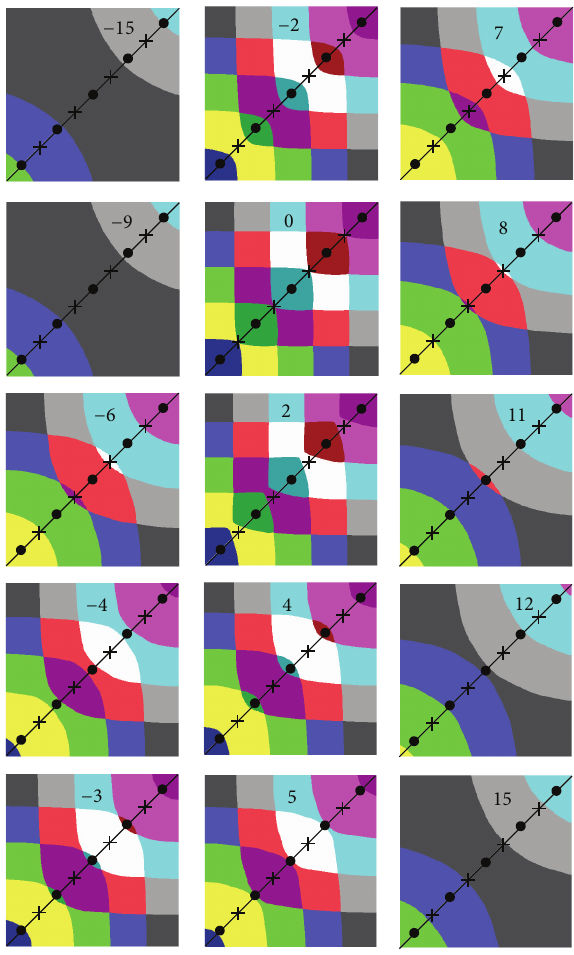
Figure 7: The projections of cross-sections into 𝑢 2 , 𝑢 1 plane for the parameters (5) and current denoted in the figure (in mA), where N 2, N 3 𝑖 = 0.94 mA and N 1, N 4 𝑖 = 2.65